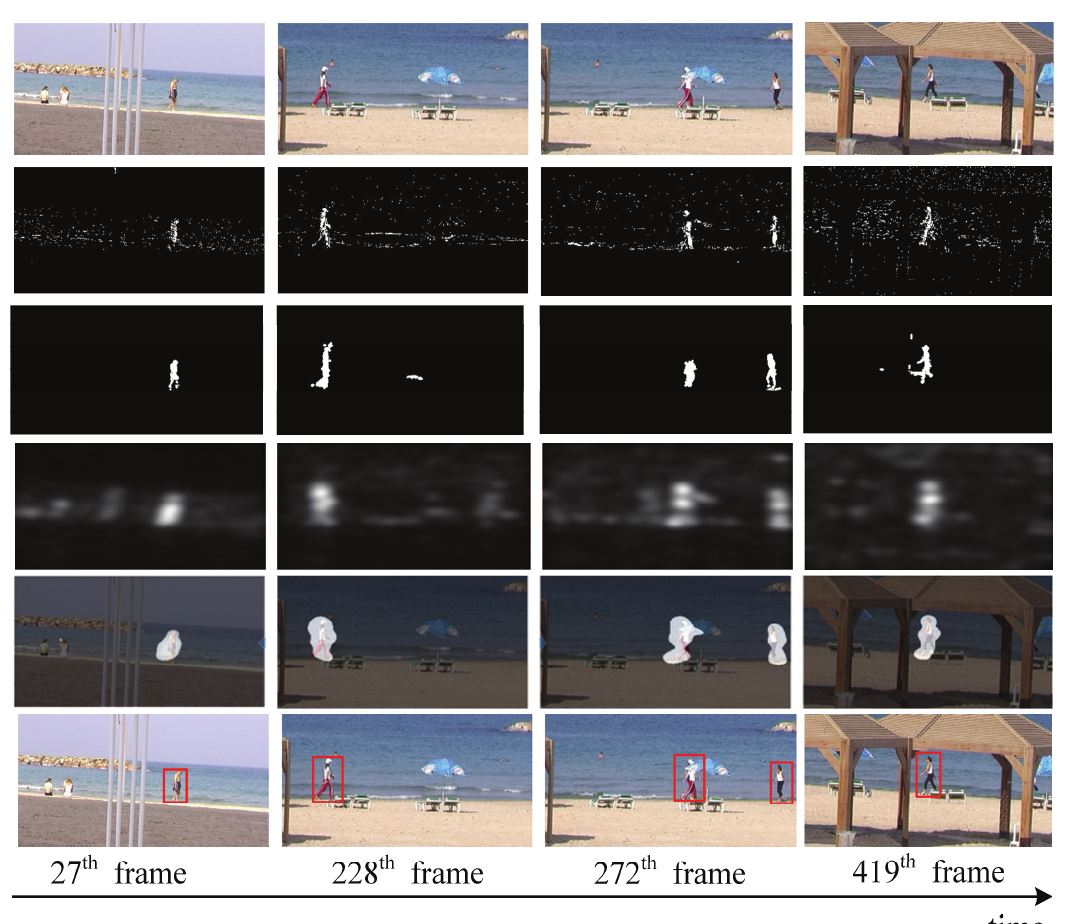
Figure 11. Comparison of two methods of spatio-temporal saliency maps in video sequences. The first row is the raw video of a dynamic background beach video [49]; the second to fourth row are results produced by GMM [47], KDE [48], our method (HSC), mask of moving object extraction results by our method and box label of moving object extraction results by our method,